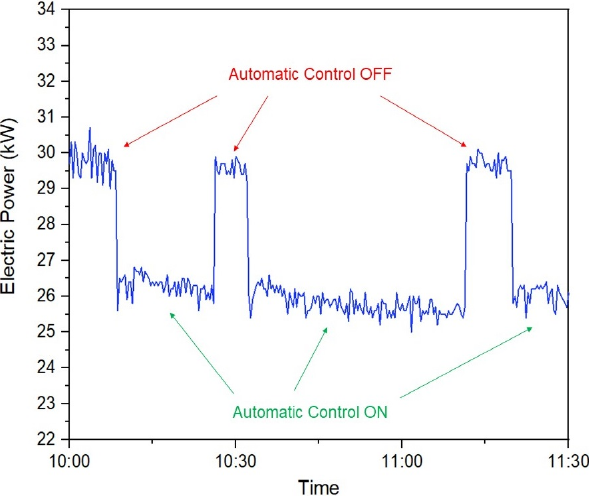
Figure 7. Impact of the performance of the logical model on electricity consumption.